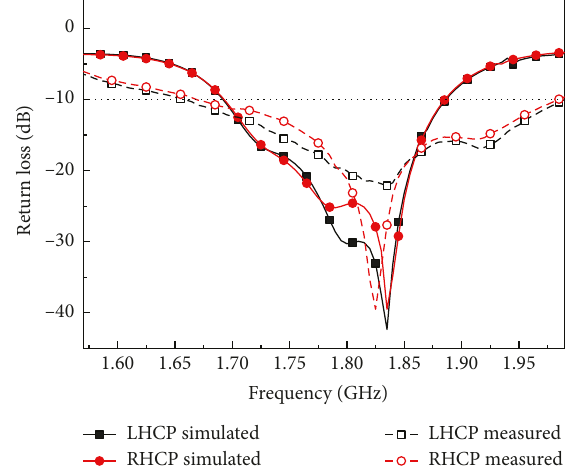
Figure 7: Simulated and measured S11.